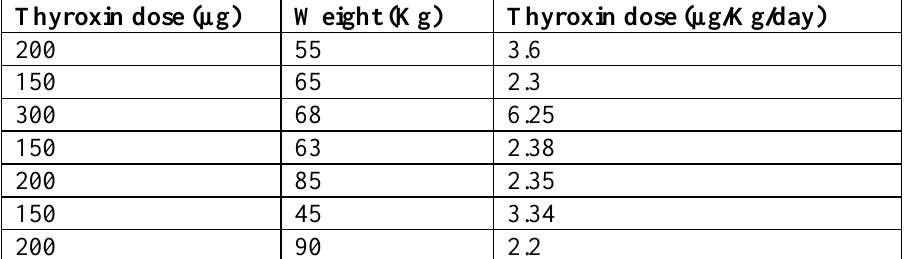
Table 12: shows the dosage of thyroxin /kg/day needed to normalize TSH.